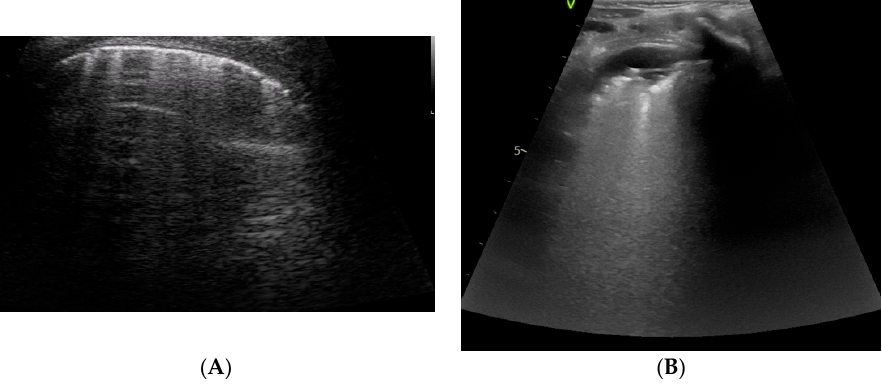
Figure 7. ( A ) B-lines due to cardiogenic lung congestion (regular, uniformly distributed along the lungs, with a regular pleural line) and ( B ) B-lines typical of a lung disease (irregular, patchy, with altered pleural line) (Video S3).